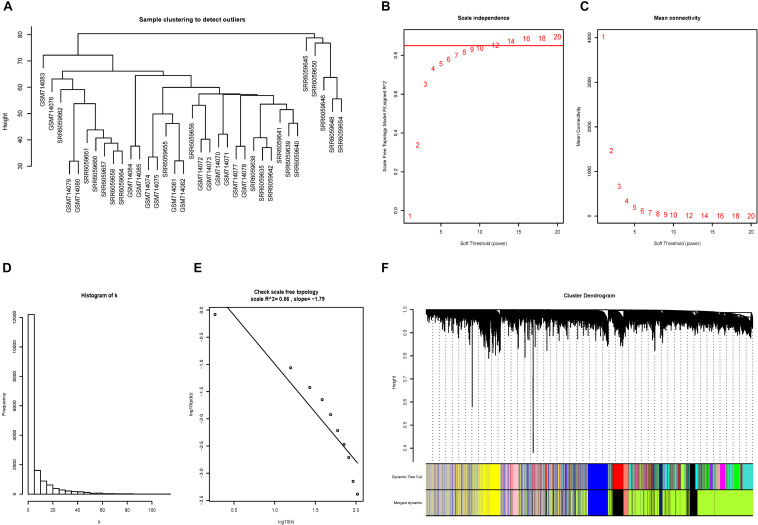
Construction of the co-expression network for advanced plaque. (A) No outliers were detected in the sample clustering and all samples were included in further study. (B,C) The cut-off for soft-threshold β was set to be 0.85 and β = 14 was selected. (D,E) The co-expression network we constructed met the requirements of scale-free topology. (F) In advanced plaque sample, 7 gene modules were detected.